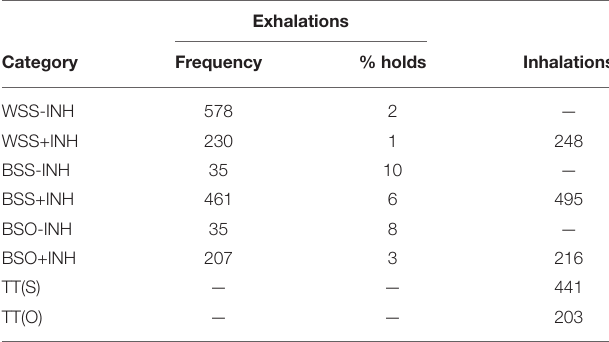
TABLE 1 | Frequencies of the analyzed turn-taking categories, alongside the percentage of instances in each category coinciding with a respiratory